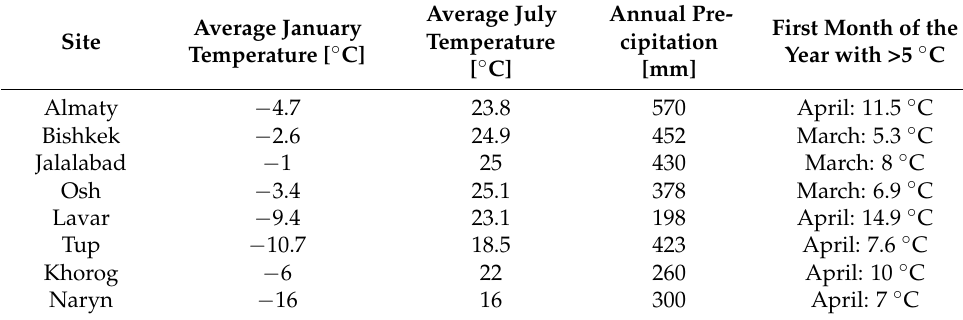
Table 3. Climate features at the sites (www.weatherbase.com, accessed on 16 March